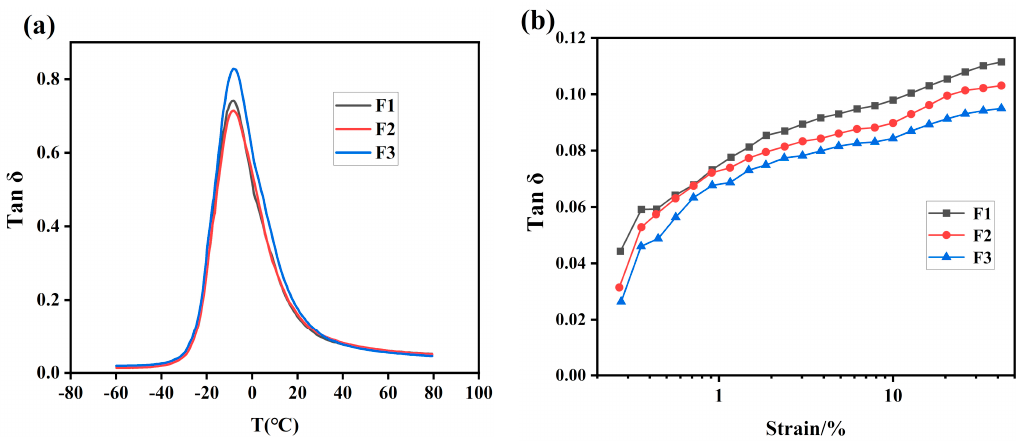
Figure 8. Dynamic properties of E25-SSBR/BR composites with different ratio of ESSBR/SSBR: ( a ) the relation of the tan δ with temperature and ( b ) the relation of the tan δ with strain amplitude.